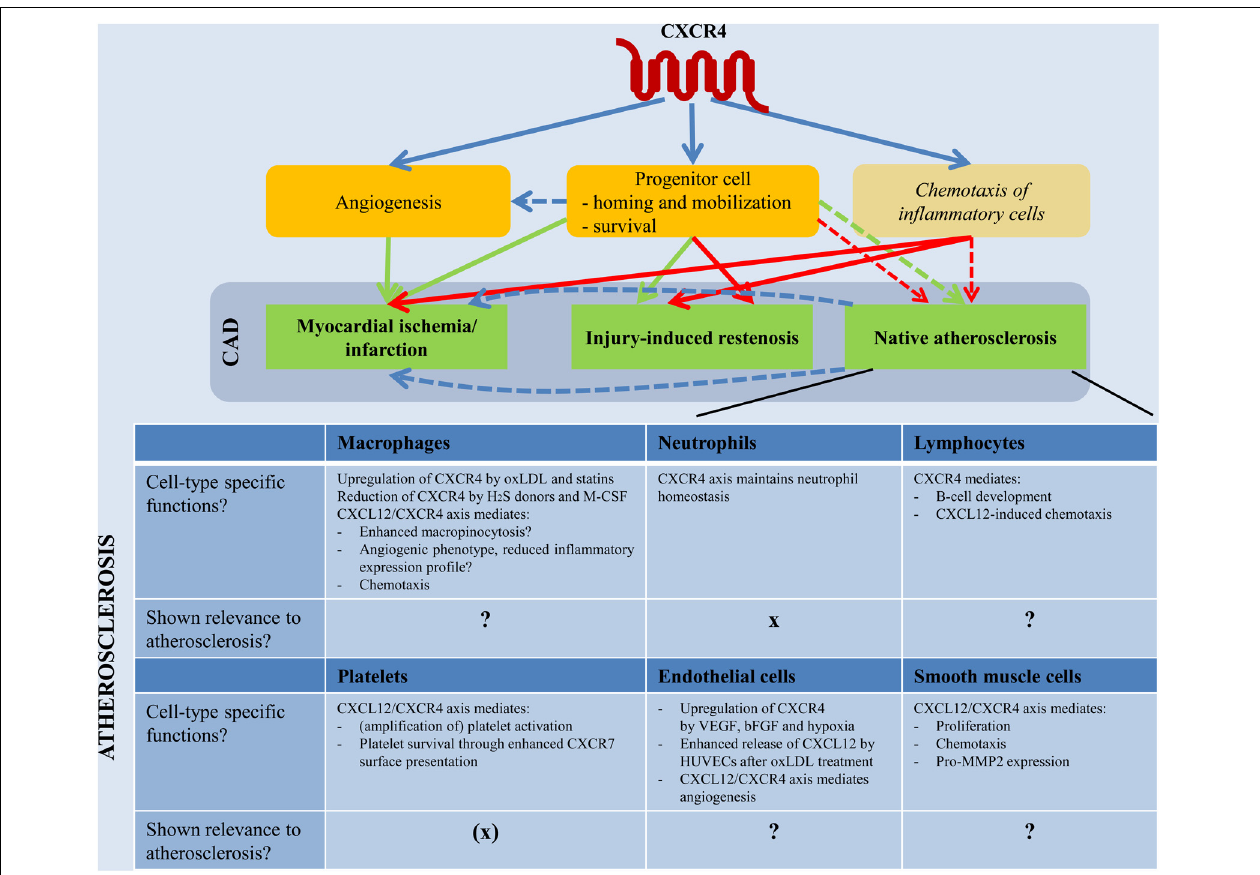
FIGURE 3 | Involvement of CXCR4 in CAD. The chemokine receptor CXCR4 plays a role in angiogenesis. Furthermore, it is an important regulator of homing, mobilization and survival of progenitor cells. This has linked CXCR4 with a role in myocardial ischemia and injury-induced restenosis, but its significance in the context of native atherosclerosis remains unclear. CXCR4 has also been reported to mediate leukocyte chemotaxis in specific inflammatory diseases. A similar role in inflammatory cell recruitment has been suggested in the context of myocardial ischemia, but the importance of CXCR4-induced leukocyte recruitment to atherosclerotic lesions in vivo remains to be further addressed. The current view mainly emphasizes the involvement of inflammatory chemokines instead of the homeostatic chemokine CXCL12 in mediating atherogenic leukocyte recruitment. However, CXCR4 can mediate both CXCL12- and MIF-induced chemotaxis of